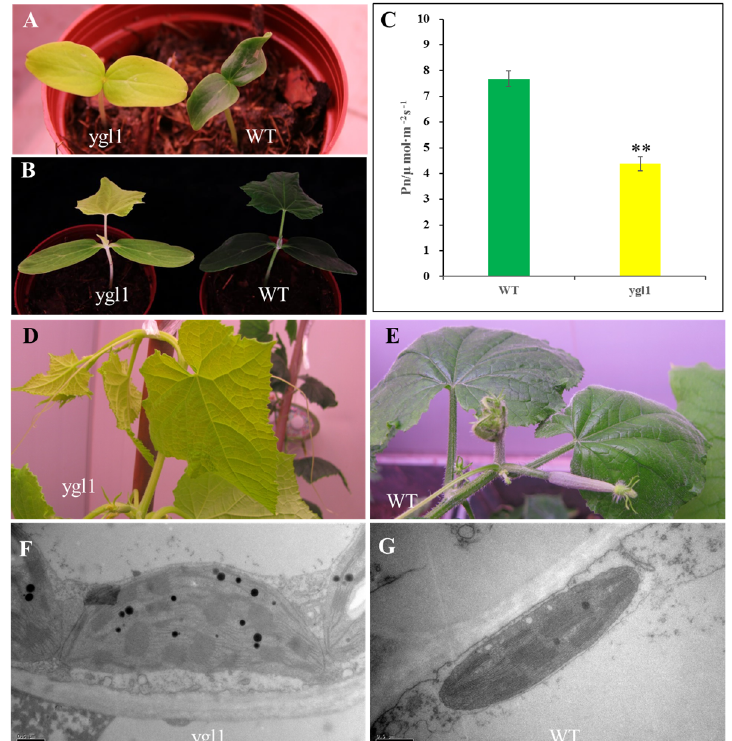
Figure 1. Phenotypic characterization of the cucumber ygl1 mutants. ( A ) One-week-old plants. ( B ) Three-week-old plants. ( C ) Net photosynthesis rate of leaves in ygl1 and wild type (WT) “1402” in cucumber. n = 10, ** stands for significant difference ( p < 0.01). ( D , E ) Twelve-week-old plants. ( F ) Chloroplasts of three-week-old ygl1 mutant have abnormal thylakoid lamellar structure to those of ( G ) the wild type with well-ordered thylakoid lamellar structure in three-week-old plants. Bar equals 0.5 µ m. Table 1. Pigment (Pig) contents in leaves of wild-type and ygl1 mutant, in mg/g fresh weight. Growth Stage